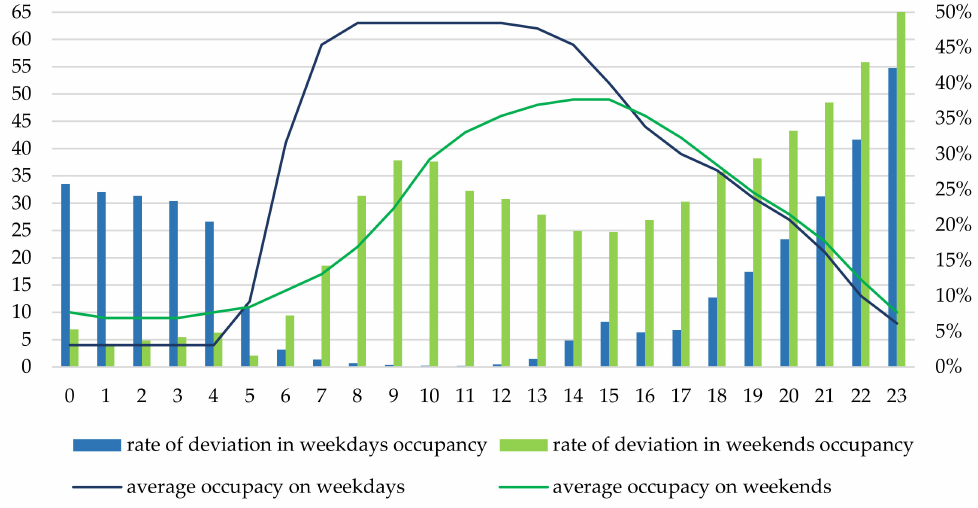
Figure 2. Similarity of parking occupancy data between weekdays and weekends.